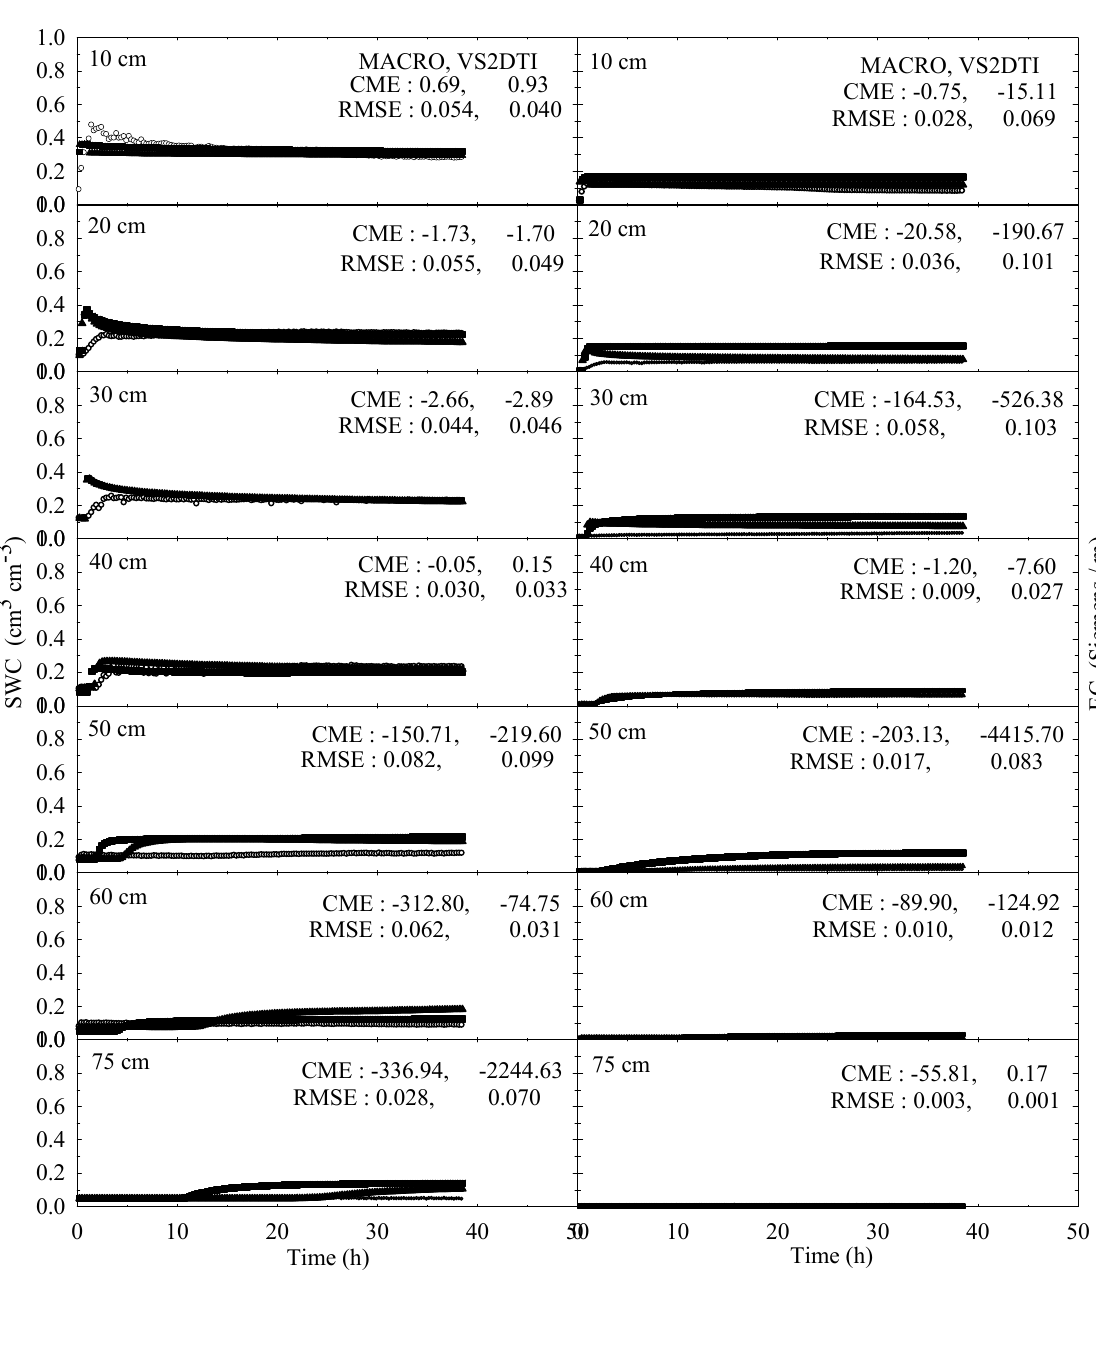
Figure 3. Spatial and temporal variability of soil water content (SWC) and electrical conductivity (EC) in the treatment of Sandy loam + Undisturbed + Dry + High. The symbols of ○ , ▲ , and ■ represent the measured and model (MACRO and VS2DTI) values, respectively. CME and RMSE are the coeficient of model efficiency and the root mean square error,